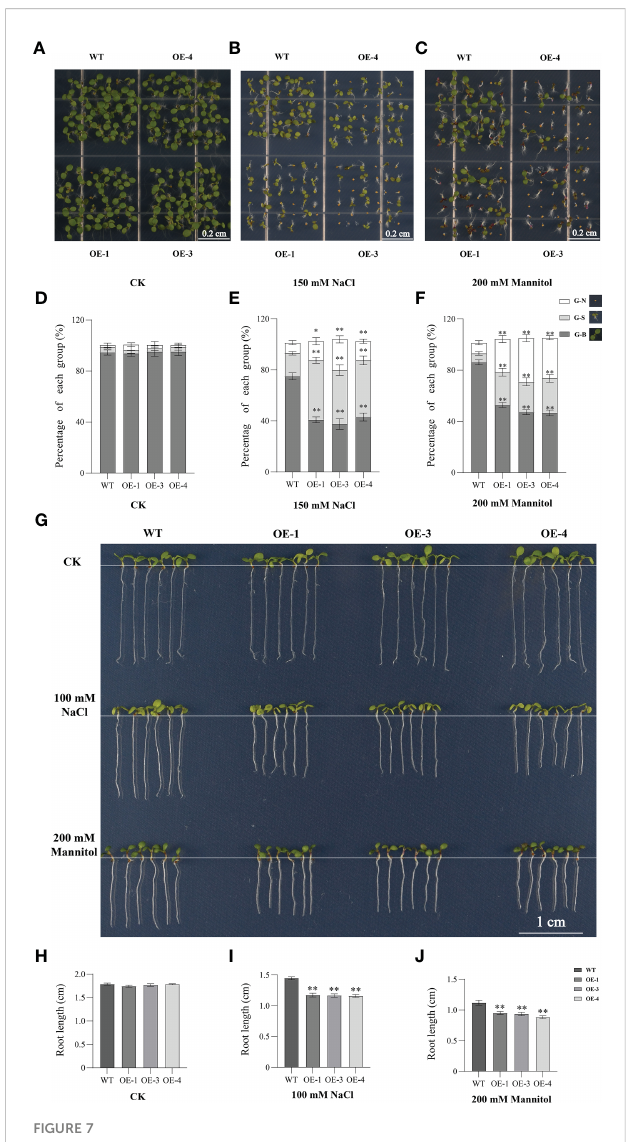
FIGURE 7 Overexpression of TaHSFB4-2B negatively regulates NaCl, and mannitol induced stress tolerance of arabidopsis. (A – C) Seeds of WT and TaHSFB4-2B overexpression lines of arabidopsis (OE-1, OE-3 and OE-4) were sterilized and plated on 1/2 Murashige and Skoog medium (1/2 MS) plates or with 150 mM NaCl or with 200 mM mannitol and growing for 10 days. (D, E) The seed germination rates and growth under corresponding treatment were quanti fi ed. (G – J) Root phenotypes of wild type and OE-1, OE-3 and OE-4 lines were shown and root length was measured and quanti fi ed. G-N 、 G-S and G-B represent ungerminated seeds, inhibited-growing seedlings and normal-growing seedlings respectively. Values are Mean ± SD, n=3. * P < 0.05 and ** P < 0.01 (Student ’ s